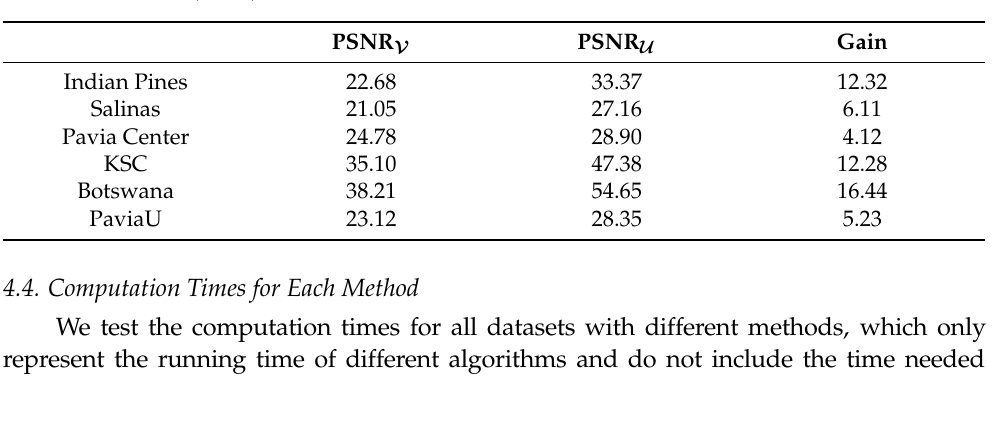
Table 6. Quantitative comparisons of the probability tensors before and after the denoising stage in terms of the PSNR (in dB) value on the six datasets in ten